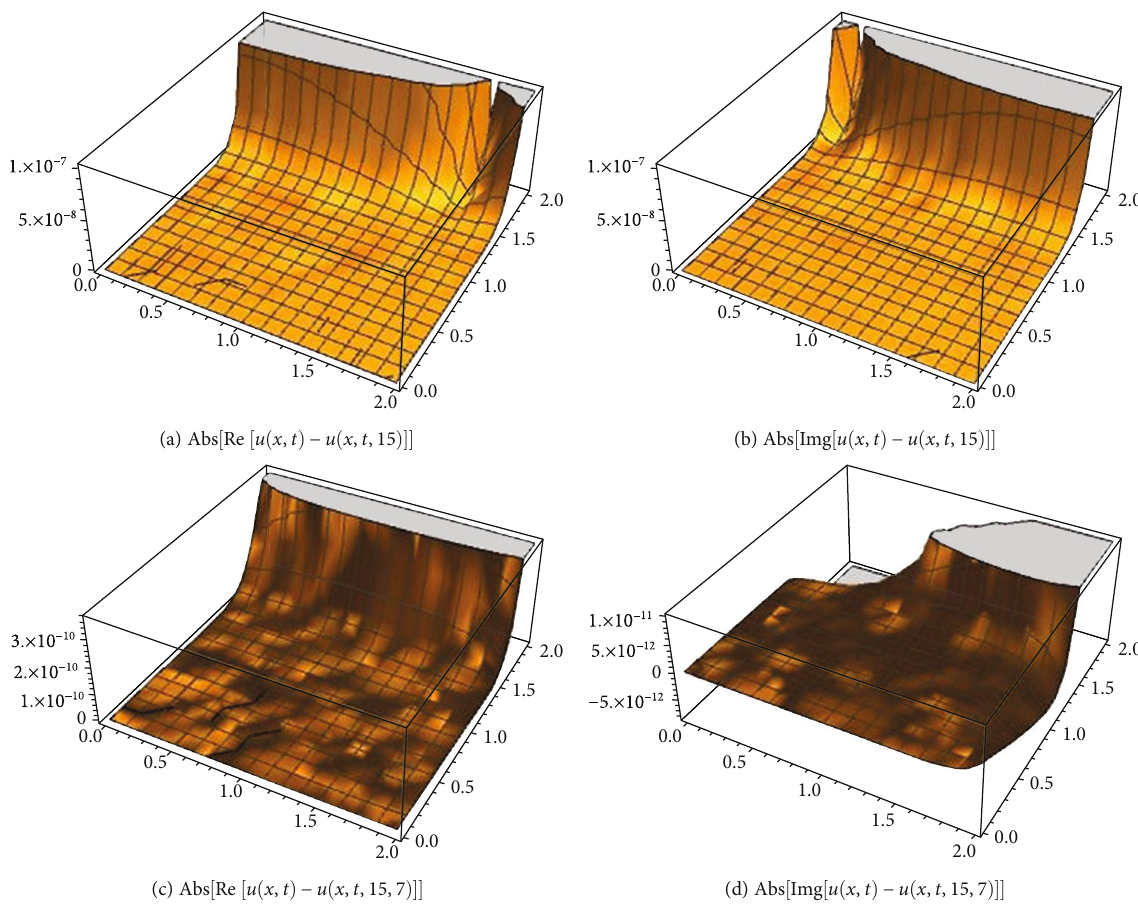
Figure 9: Absolute